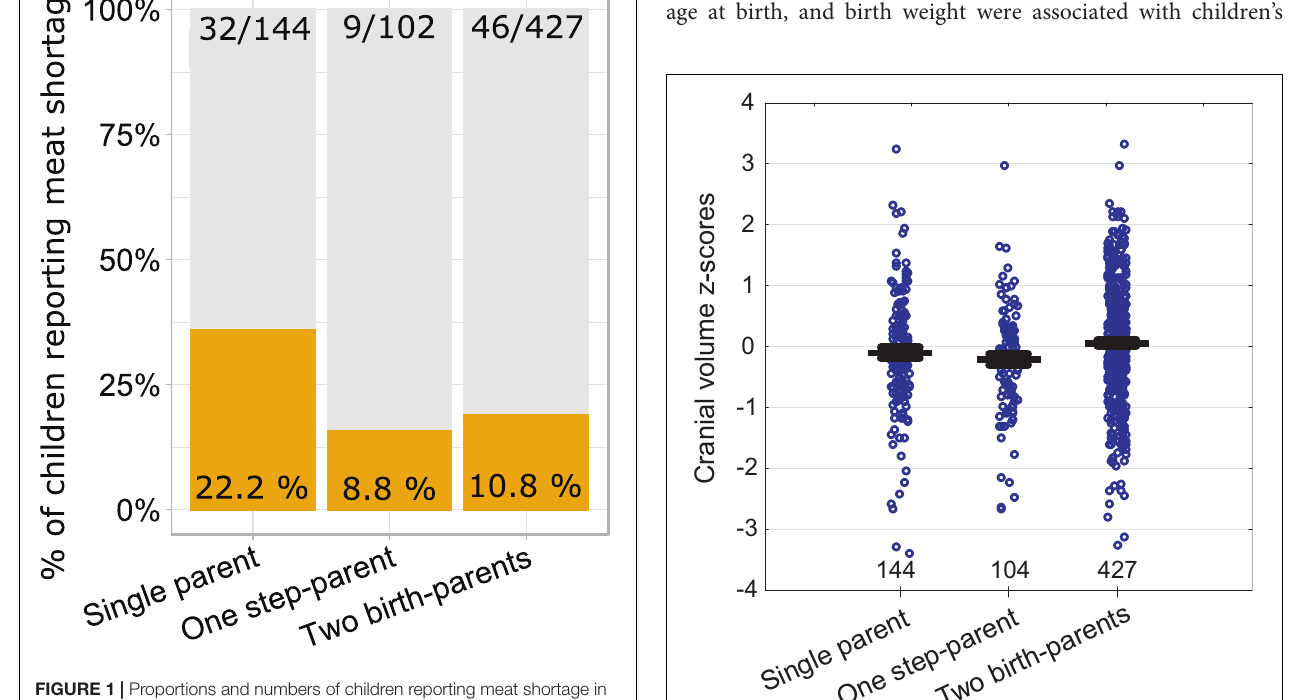
FIGURE 1 | Proportions and numbers of children reporting meat shortage in relation to family type. Single-parent families have a higher proportion of children reporting meat shortage than two-provider families with a step-parent ( χ 2 = 7.7, p = 0.005) or two birth-parents ( χ 2 = 14.3, p = 0.0008). The latter two categories do not differ from each other ( χ 2 = 0.3, p = 0.562).